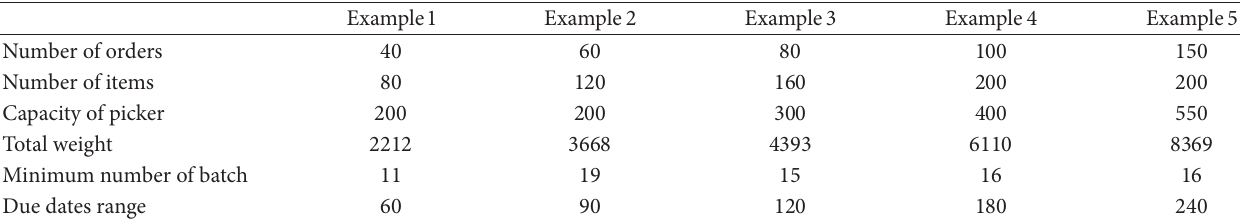
Table 5: Test problems description.